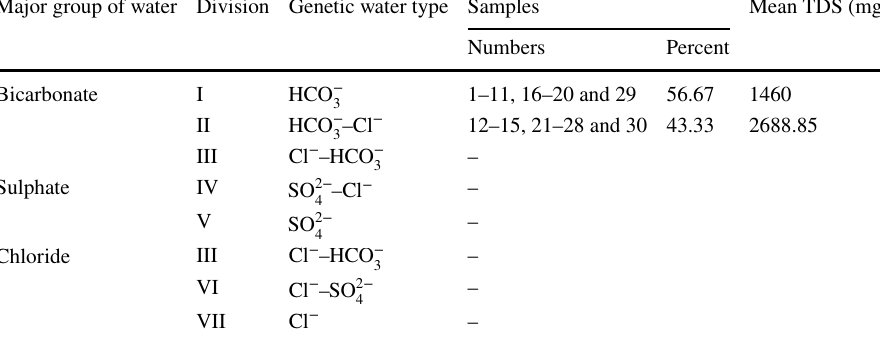
Table 3 Geochemical classification of groundwater (Chebotarev